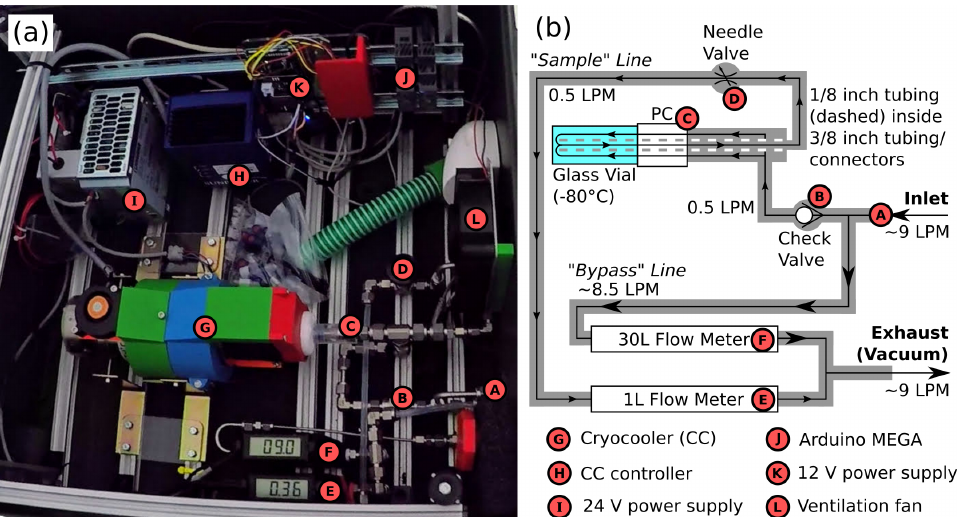
Figure 3. The cold-trapping module. (a) Interior of the module; cryocooler is surrounded by green, blue and red plastic near photo center (“G”). (b) Flow diagram for the module. “PC” indicates placement of polycarbonate vial adapter. See text for